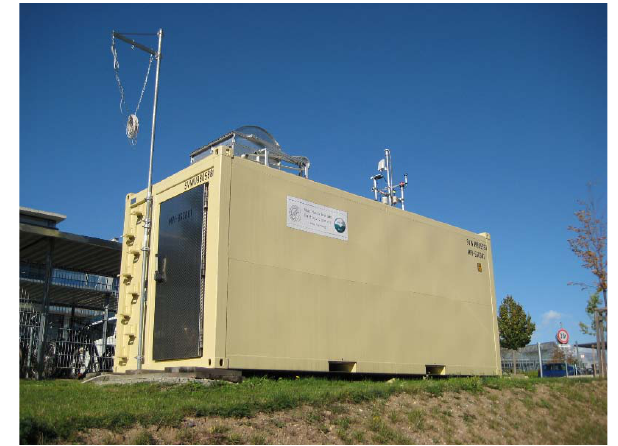
Fig. 1. Picture of the MPI-BGC FTIR container at its preliminary location close to the MPI-BGC in